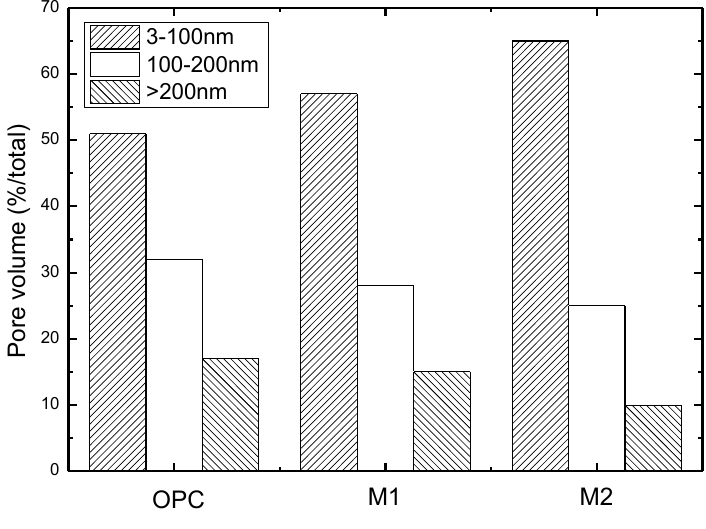
Figure 4. Pore size distribution of concrete immersed in deionised water for 180